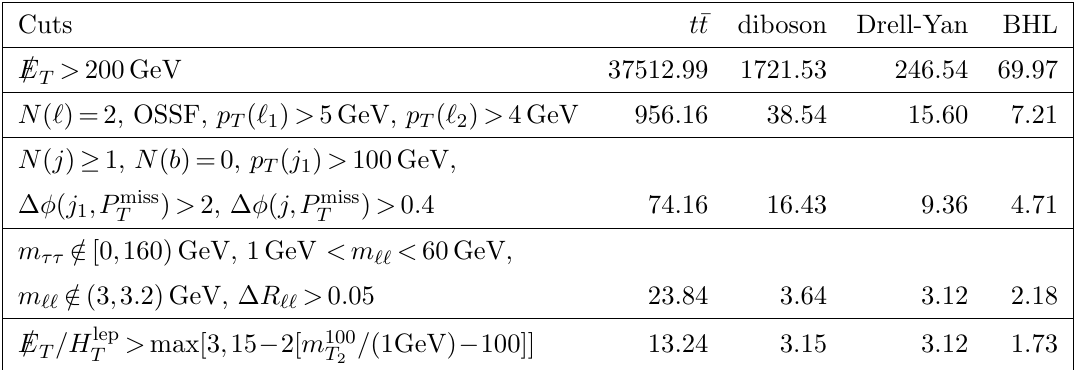
Table 2 . The cut (cid:13)ow for the cross sections of the signal and backgrounds at the 27 TeV HE-LHC for the BHL benchmark point m are in units of